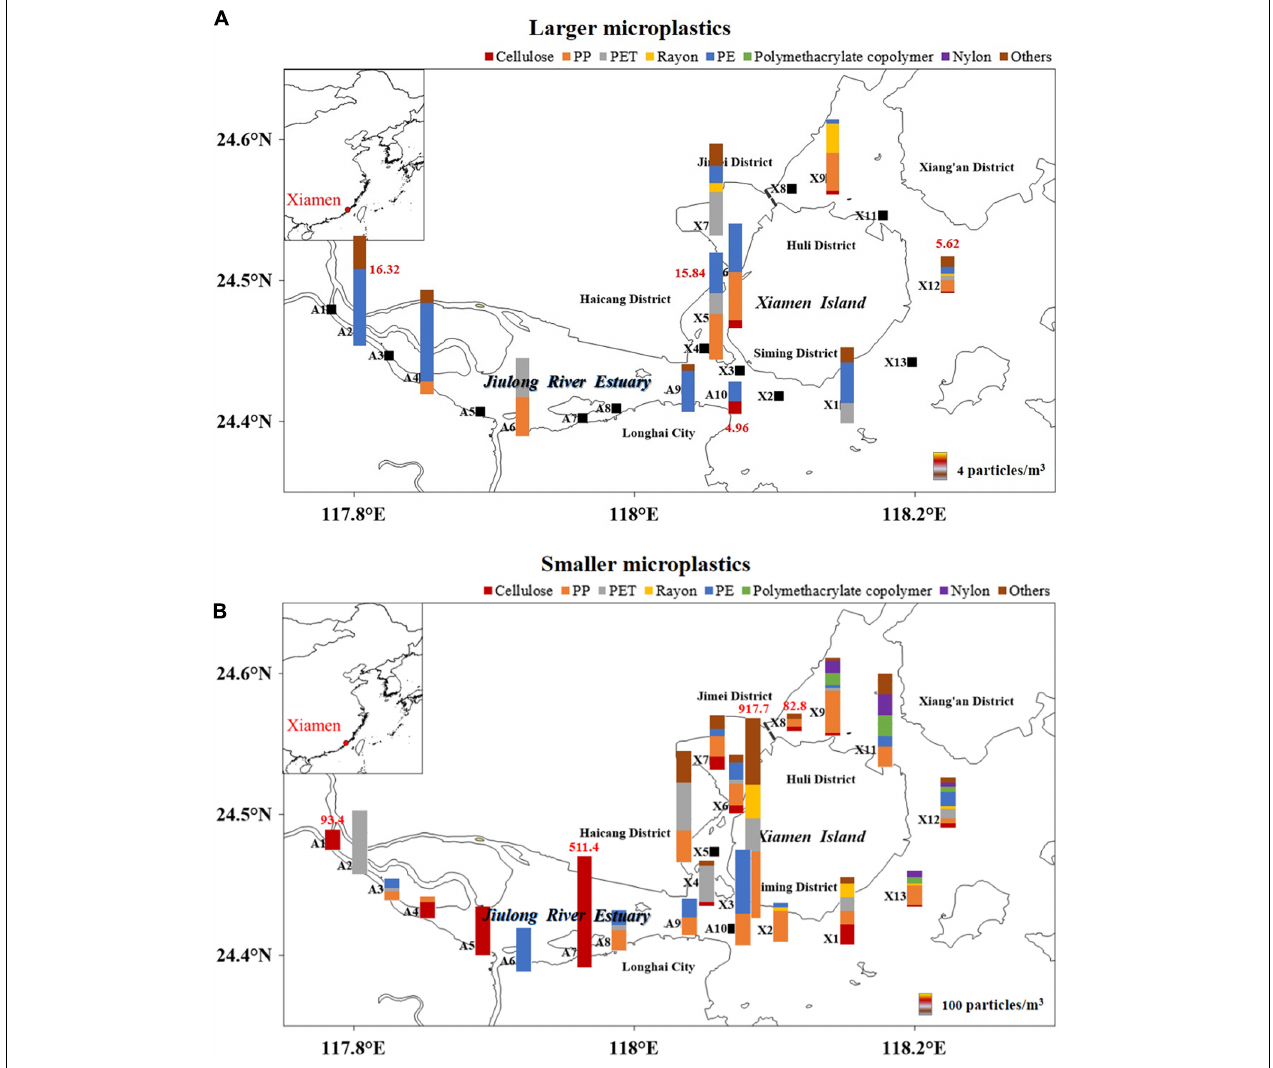
FIGURE 2 | The abundances of larger (A) or smaller (B) microplastics in Xiamen Bay and the Jiulong River Estuary. The length of vertical bars indicates microplastic abundance, and different colors in the figures represent different compositions of